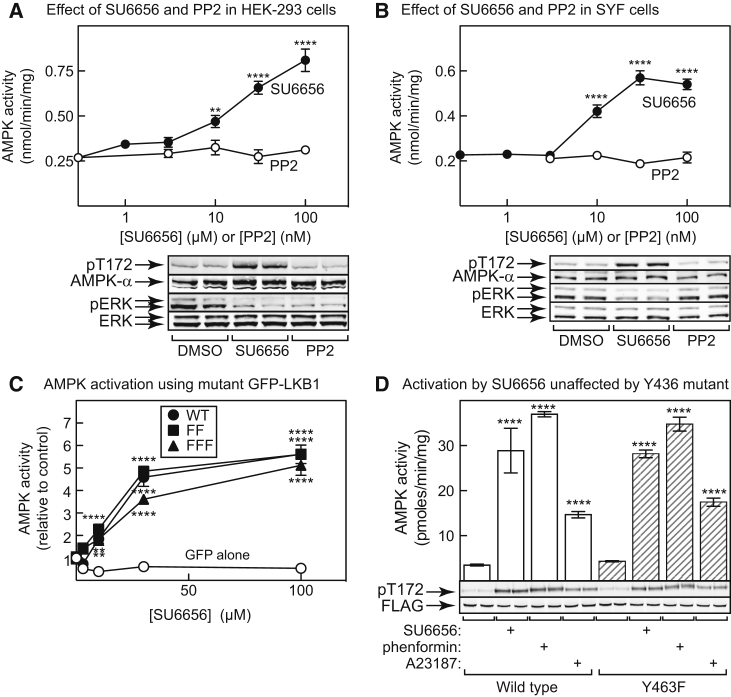
AMPK Activation by SU6656 Does Not Require an Src Family Kinase or Tyrosine Phosphorylation of Either LKB1 or AMPK(A) HEK293 cells were incubated with the indicated concentrations of SU6656 or PP2 for 1 hr and AMPK activity assayed. Top: AMPK activity (mean ± SEM, n = 4); bottom: western blots showing phosphorylation of Thr172 on AMPK, and of ERK1/2, in cells treated with DMSO (control), SU6656 (100 μM), or PP2 (100 nM) (n = 2).(B) As (A), but in SYF cells.(C) HeLa cells were transfected with DNAs encoding GFP alone, or GFP fused to WT, Y261F/Y365F (FF), or Y36F/Y261F/Y365F (FFF) mutants of LKB1; cells were treated with increasing concentrations of SU6656 for 1 hr and AMPK activity determined (mean ± SEM, n = 4). See also Figure S1.(D) HEK293 cells were transfected with DNAs encoding FLAG-tagged AMPK-α2 with or without a Y436F mutation. Cells were incubated with DMSO (control), 100 μM SU6656, 10 mM phenformin, or 10 μM A23187 for 1 hr; AMPK complexes were immunoprecipitated using anti-FLAG antibody and assayed. The top panels show kinase activities (mean ± SD, n = 3); the bottom panels show blots from the same experiment (n = 2).In all panels, asterisks indicate significant differences from DMSO controls; in (D), there were no significant differences between the WT and Y463F mutant. **p < 0.01, ****p < 0.0001.